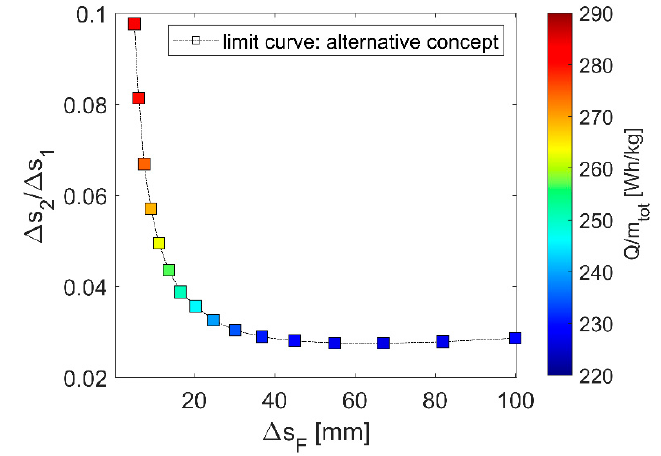
Figure 10. Ratio of outer to inner thermal insulation thickness ( Δ s 2 / Δ s 1 ) and gravimetric systemic storage densities (Q/m tot ) for the limit case as a function of the cooling fluid gap ( Δ s F ).